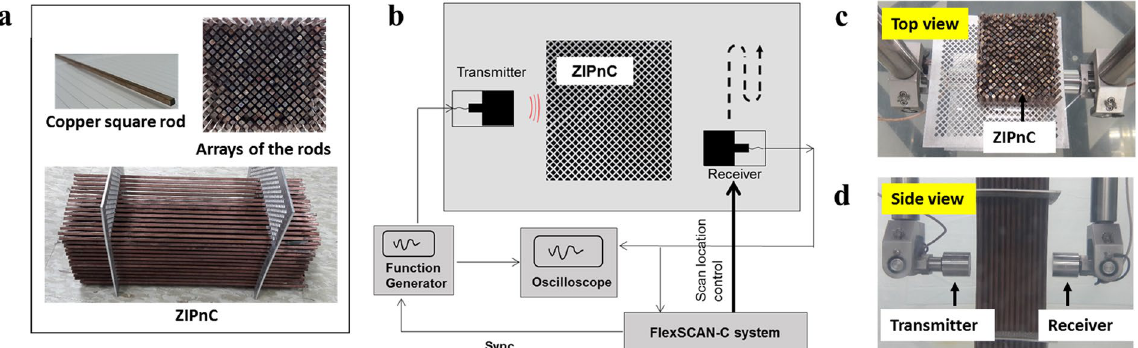
Figure 4. Experimental setup and measurements: ( a) Copper square rod used for the periodic inclusions, the DZIPnC and corresponding side view. The DZIPnC has a unit-cell lattice of 15 × 13 with d 1 = 2.26 mm and d 2 = 6.34 mm. (b) Setup for the experiment on the DZIPnC with the receiver controlled by a motorized scanning system. (c) Top-view and (d) side-view snapshots of the experiment in a water tank. The transducers on the left and the right are the transmitter and receiver, respectively.